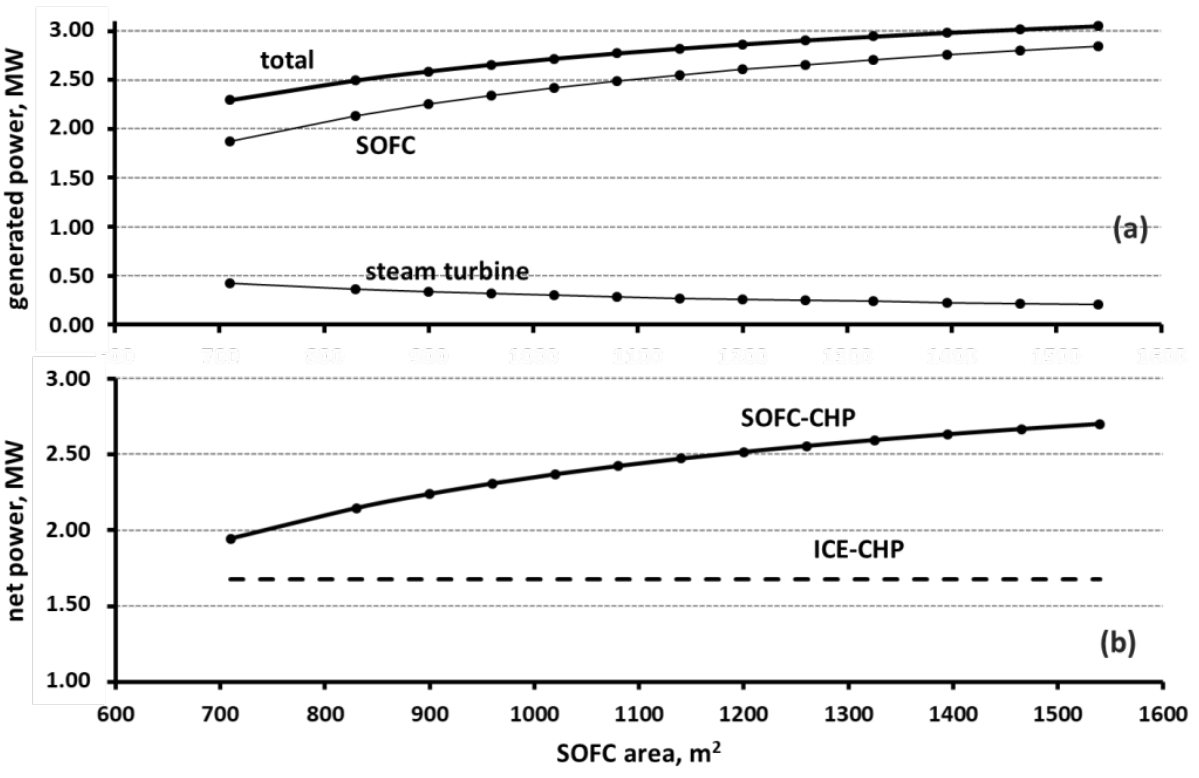
Figure 4. Biogas plant power generation and its dependence on the employed SOFC unit size, for 750 m 3 · h − 1 biogas production.